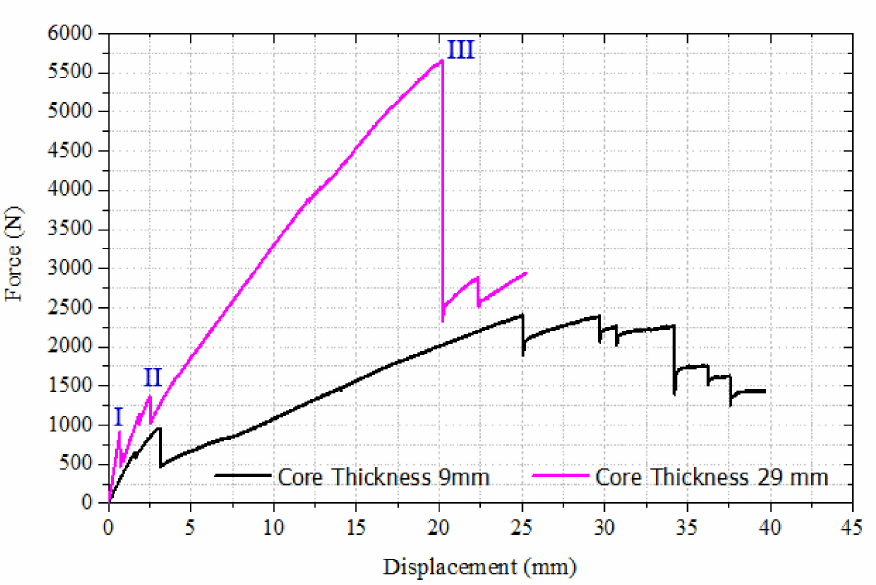
Figure 3. E ff ect of core thickness on Carbon Fiber-Reinforced Polymer (CFRP) facesheet / PU foam sandwich beam under four-point flexural loading at a displacement rate of 0.05 mm /